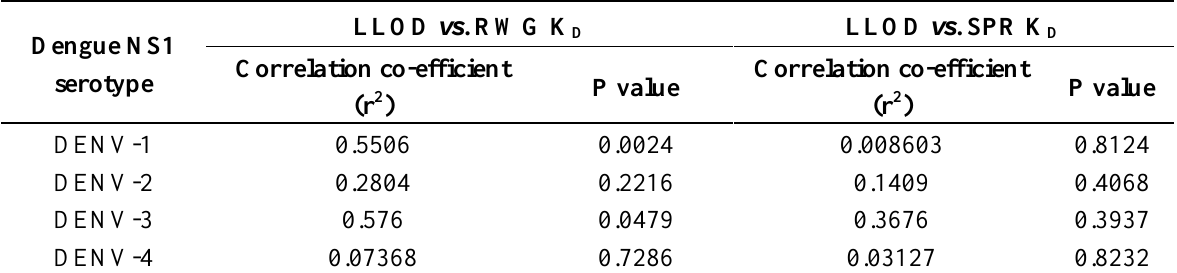
Table 3. Correlation of RWG and SPR affinities with enzyme linked immunosorbent assay (ELISA) lower limit of detection